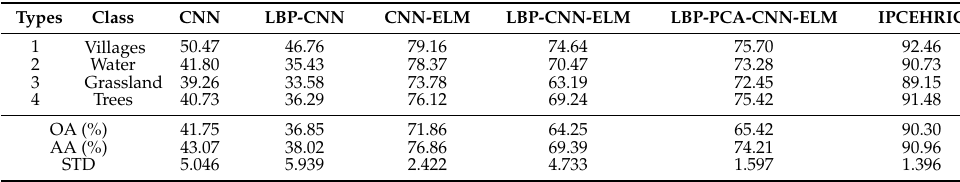
Table 7. The classification results of HRSIs for four types (%).